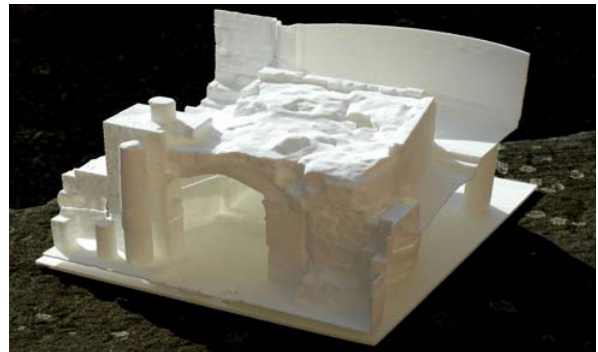
Figure 10. Solid model of the Grotto of the Annunciation (Nazareth, Palestine) - sinterized